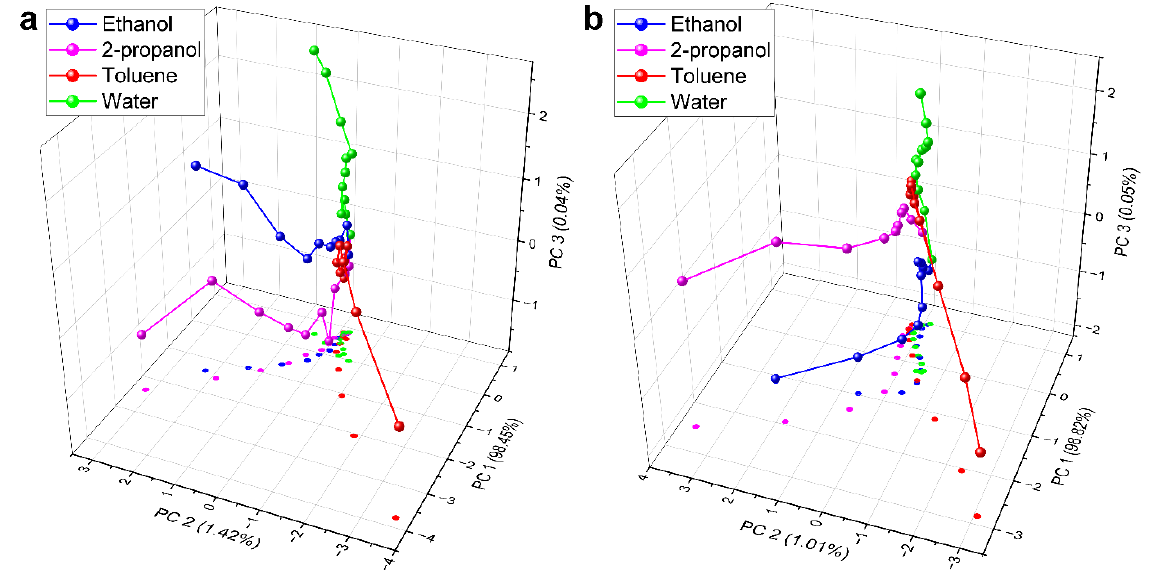
Figure 6. PCA scores plots of ethanol, 2-propanol, toluene, and water, calculated for the two graphene-covered Ag NP samples. Slightly different vapor sensing properties can be seen in ( a ) sample #1 (pristine graphene overlayer), compared to ( b ) sample #2 (defected graphene overlayer). The cumulative variance of the first three PCs was above 99% for both samples.